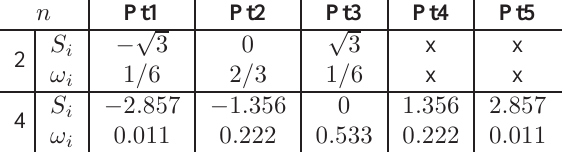
Table 1: Sigma/weights pairs ( S standard normal law